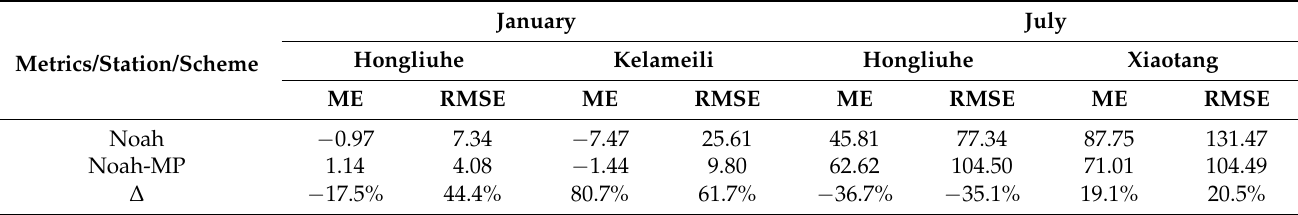
Figure 3. Daily simulation of surface soil heat flux at Hongliuhe ( a , b ), Kelameili ( c ), and Xiaotang ( d ) stations in January ( a , c ) and July ( b , d ) 2017 between Noah (red line) and Noah-MP (blue line) scheme, observation is the black line (unit: W ∙ m − 2 ). Table 2. ME and RMSE of simulated surface soil heat flux at 5 cm thickness in WRF simulations with Noah and Noah-MP scheme in January and July 2017 (unit: W ∙ m − 2 ).